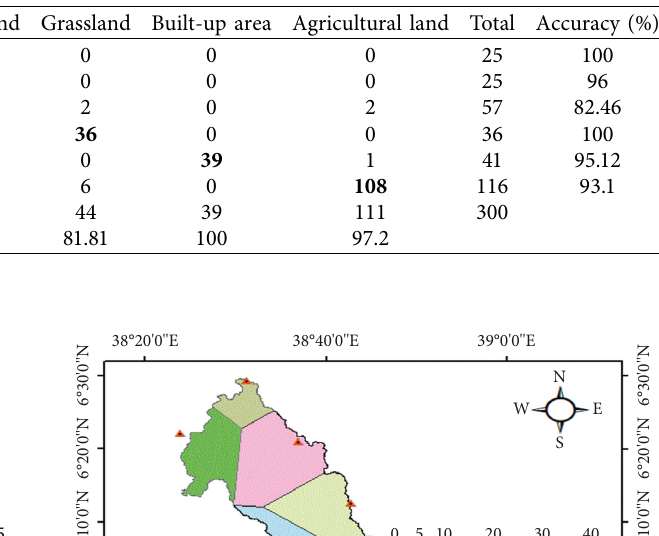
Table 4: Land use land cover image classification accuracy assessment report (error